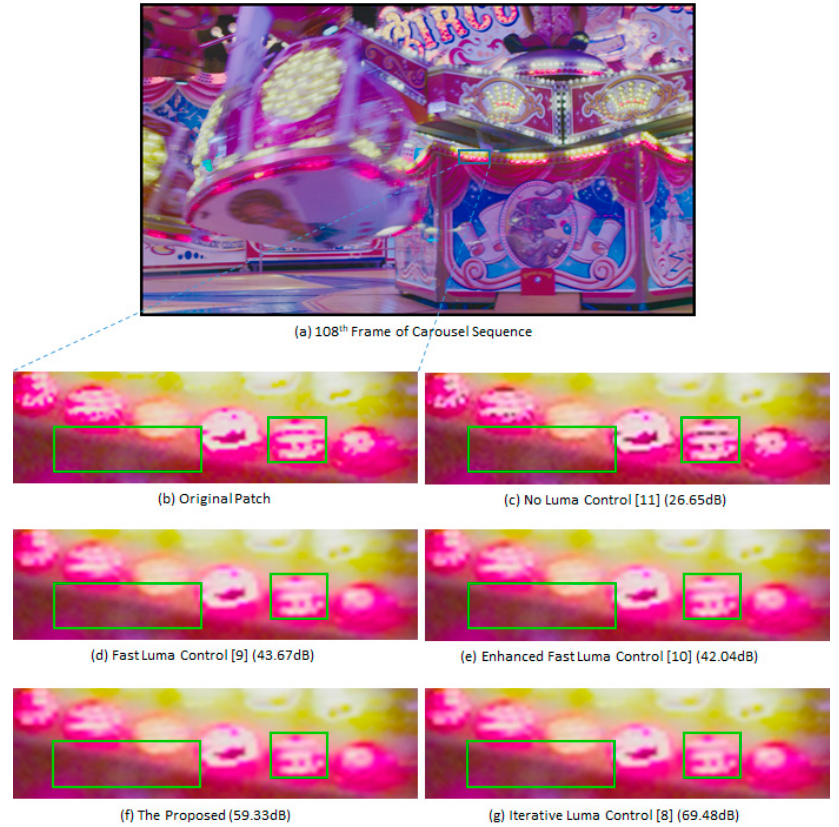
Figure 5. The visual effect comparison for the test sequence “Carousel” (108th frame). The number in parentheses for each subfigure means the tPSNR-Y value of the image patch produced by each luma control algorithm.